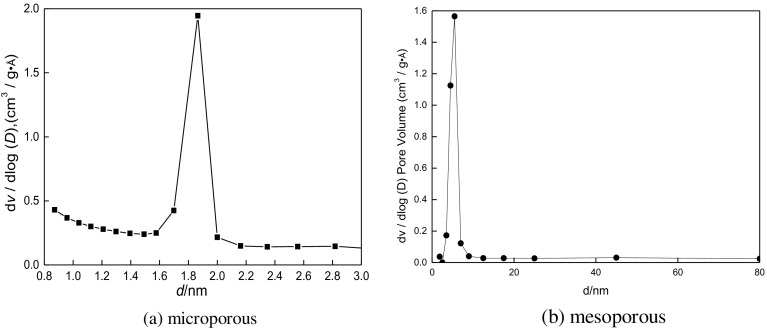
The pore size distribution curve of the micro- and mesoporous of SYS2.